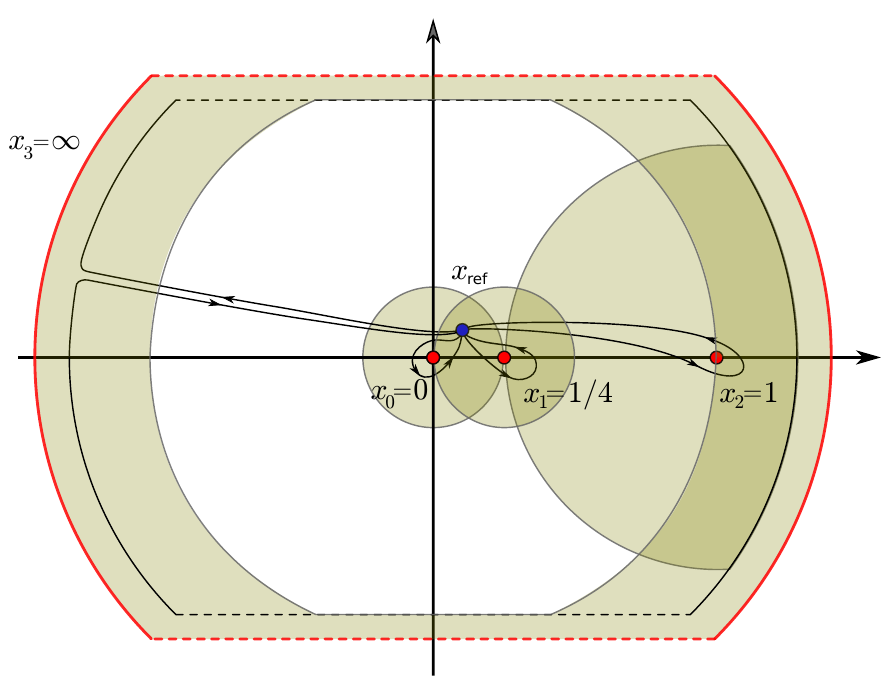
Figure 3 . Geometry of the banana differential operator in eq. (5.19). The coefficient functions have poles at ( x ) = (0 , 1 / 4 , 1 , ∞ ) . The corresponding radii of convergence are shaded in 0 , x 1 , x 2 , x 3